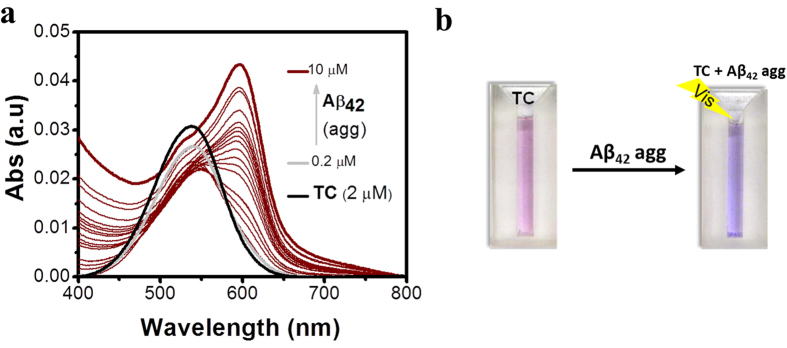
(a) Absorption (Abs) spectra of probe TC (2 μM) with increasing concentration of Aβ42 fibrils (0.2, 0.4, 0.6, 0.8, 1.0, 1.2, 1.4, 1.6, 1.8, 2.0, 2.5, 3.0, 3.5, 4.0, 4.5, 5.0, 6.0, 7.0 and 10.0 μM). (b) Photographs of TC (2 μM) and TC (2 μM) + Aβ42 fibrils (15 μM) showing a colorimetric change from pale pink to purple.